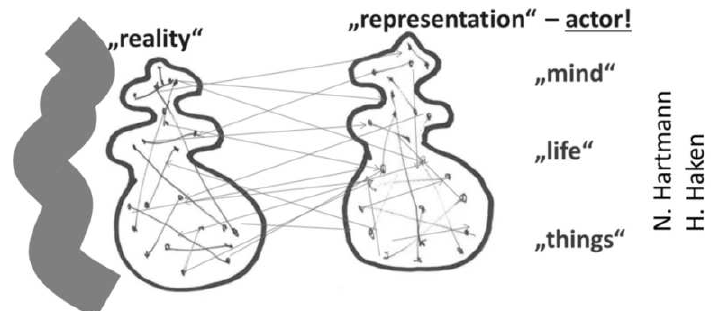
Figure 1. Overview sketch of the correspondence of the grounding of any “real thing” with internal structure (left) and partly matching links in the a conceptual multi-modal representation (middle); any schematic representation is, first of all, a data structure in and for an individual actor. Following Nicolai Hartmann, different realms/layers can be distinguished, which can be directly mapped to separated layers as devised by the synergetics of Hermann Haken. The grey area on the far left simply is out of (current) reach; in a sense, it does not even exist for the